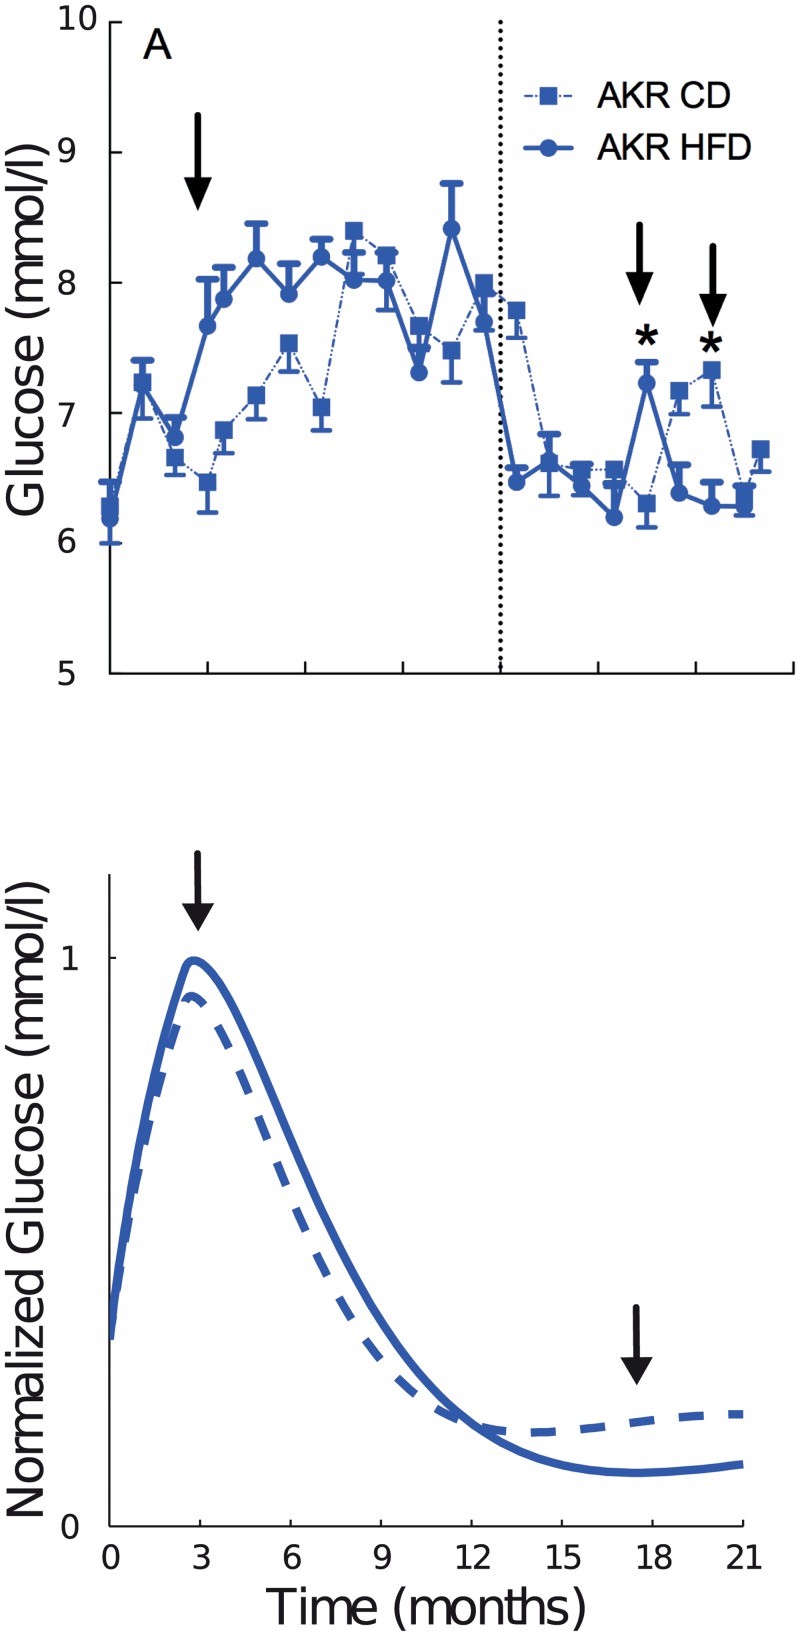
Two-peak blood glucose response.Prolonged feeding of HFD and CD till 18 months of age confirmed the second minor peak in blood glucose levels between 15 to 21 months (A), which was predicted by the second minor rise in the blood glucose simulations after 15 months. Simulations were performed by 50-fold increasing the insulin- and leptin-mediated delayed-negative-feedback (k7l, k7i) (B). Note that the simulations depict normalized glucose values. Shown are means ±SEM from n = 8–12 mice per diet. *p < 0.05 ANOVA plus Sidak’s post test comparing blood glucose levels from month 12–18.5 months (A).